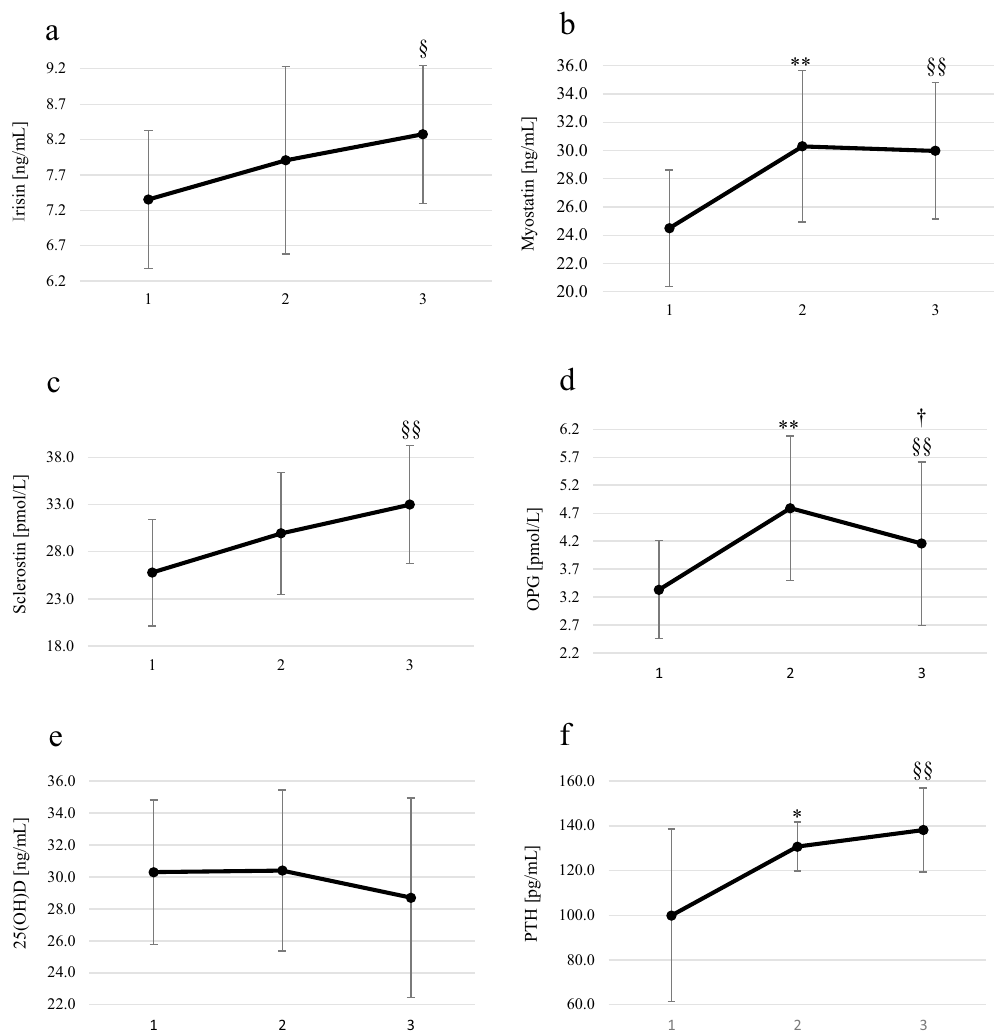
Figure 1. Blood concentrations of irisin, myostatin, sclerostin, OPG, 25(OH)D and PTH in male amateur runners before and after the Visegrad Marathon. ( a ) irisin, ( b ) myostatin, ( c ) sclerostin, ( d ) OPG, ( e ) 25(OH) D, ( f ) PTH. 1: before marathon; 2: 24 h after the marathon; 3: 72 h after the marathon. ** p < 0.01 significant differences between measurements before and 24 h after the marathon. * p < 0.01 significant differences between measurements before and 24 h after the marathon. † p < 0.05 significant differences between measurements 24 h and 72 h after the marathon. §§ p < 0.01 significant differences between measurements before and 72 h after the marathon. § p < 0.05 significant differences between measurements before and 72 h after the